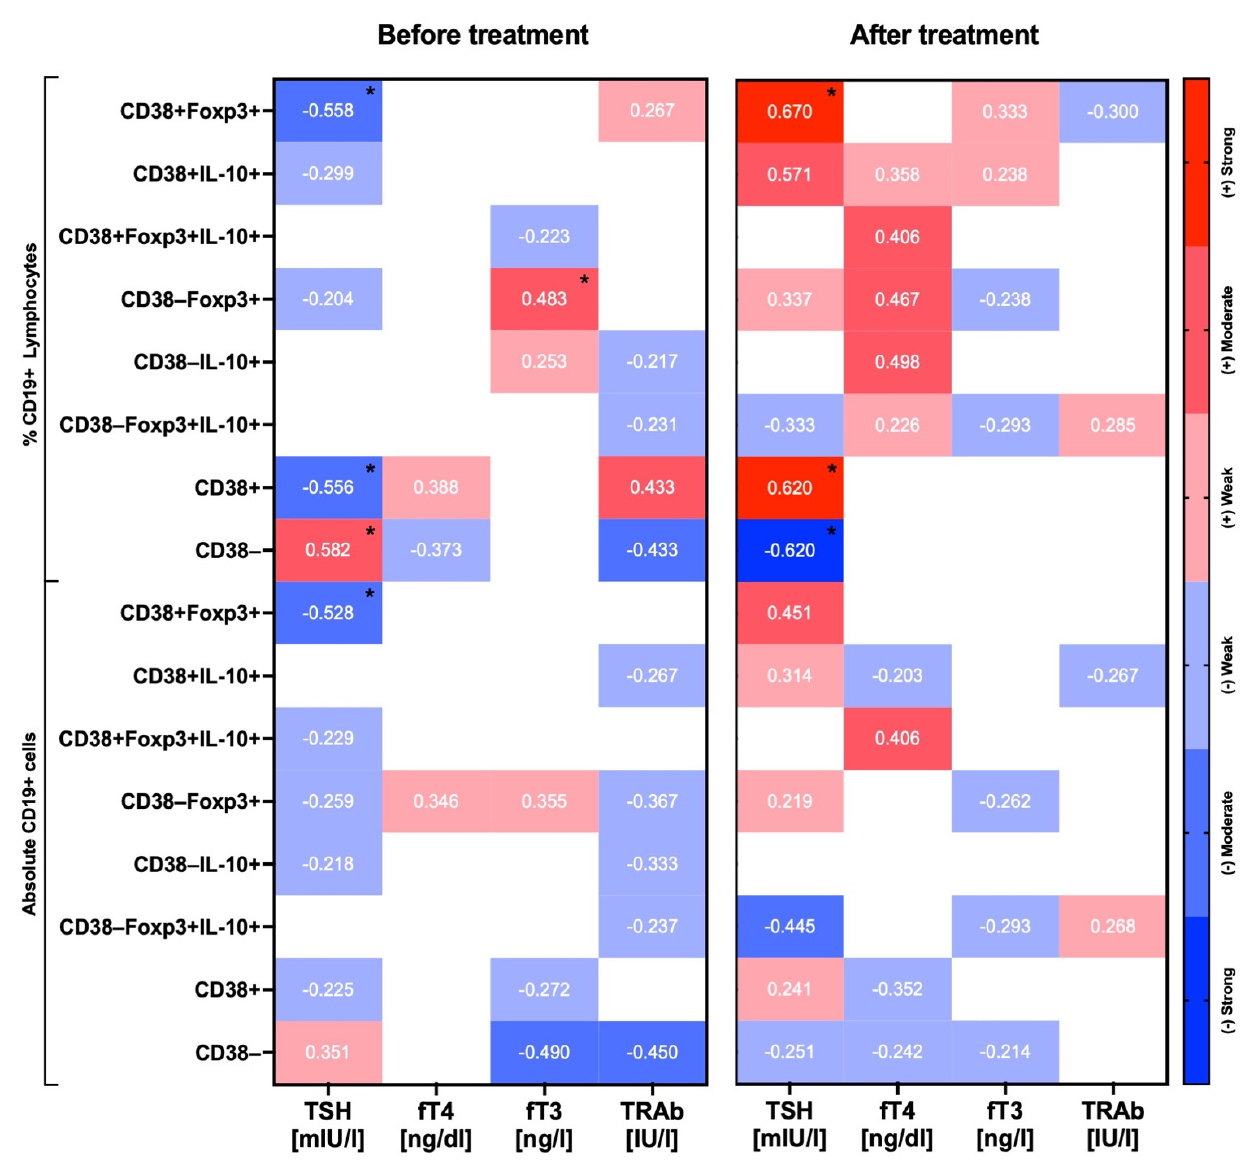
Figure 4. Correlations between essential thyroid function-related parameters and regulatory B cells in Graves’ patients. Links between studied parameters were established prior to and after treatment with methimazole. Heat maps present correlation co-efficiency values with those significant ( p -value < 0.05), indicated by asterisks. Strength of correlations was demonstrated through color gradient—blue for negative correlations and red for positive correlations ( r = − /+ 0.799–0.6—strong, r = − /+ 0.599–0.4—moderate, r = − /+ 0.399–0.2—weak correlations).